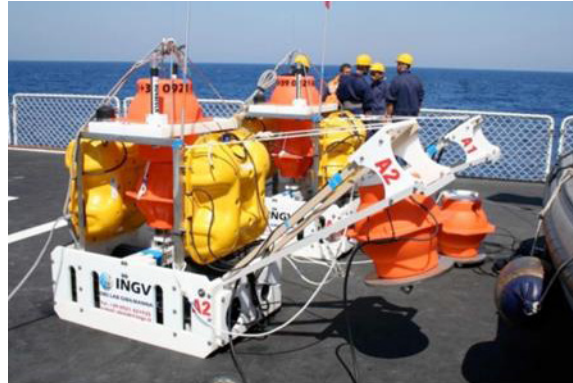
Figure 6. Italian OBS.